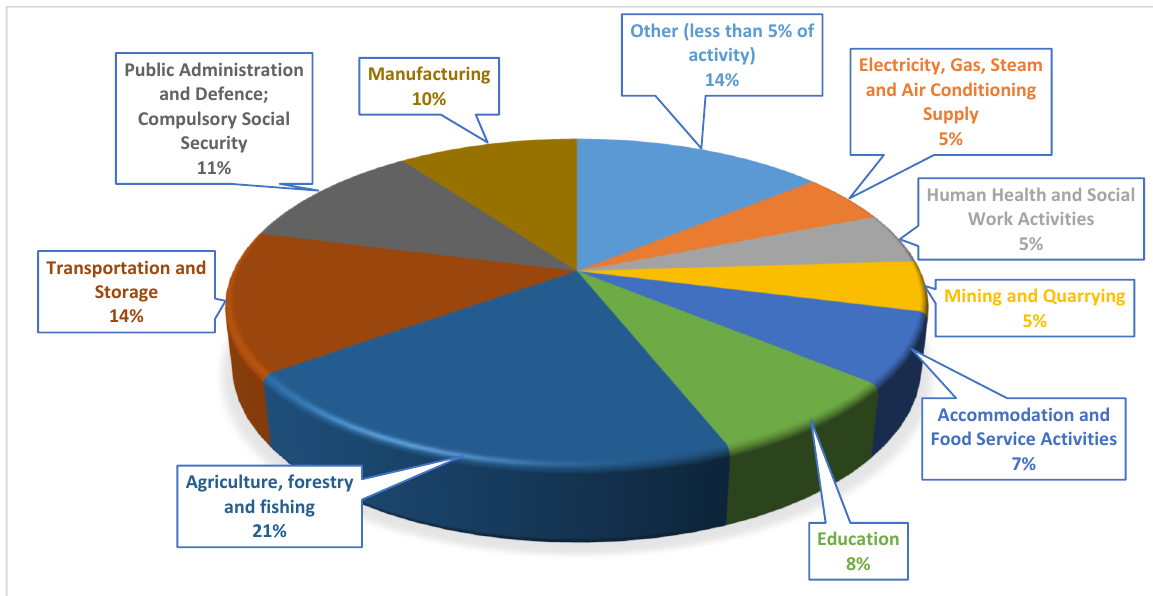
Figure 5. Structure of employment by sector in Western Macedonia, Source: Authors’ calculations using EIEAD data, 2018 [15].